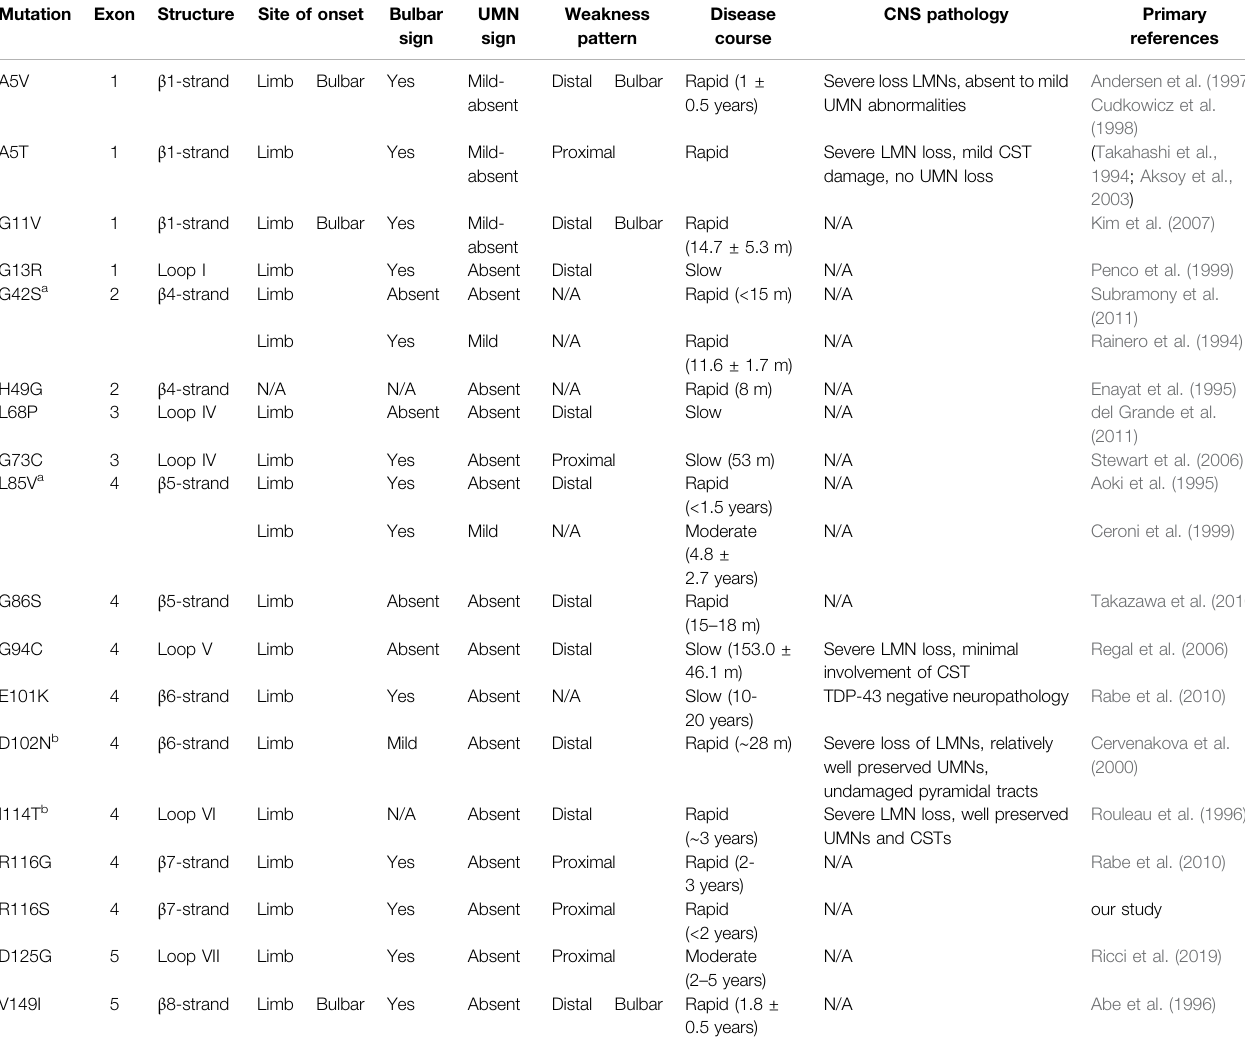
TABLE 1 | Clinical table of SOD1 fALS patients with predominant lower motor neuron symptoms, color-coded by symptom group. The reference protein sequence for mutations included in the table is NP_000445.1. Mutation Exon Structure Site of